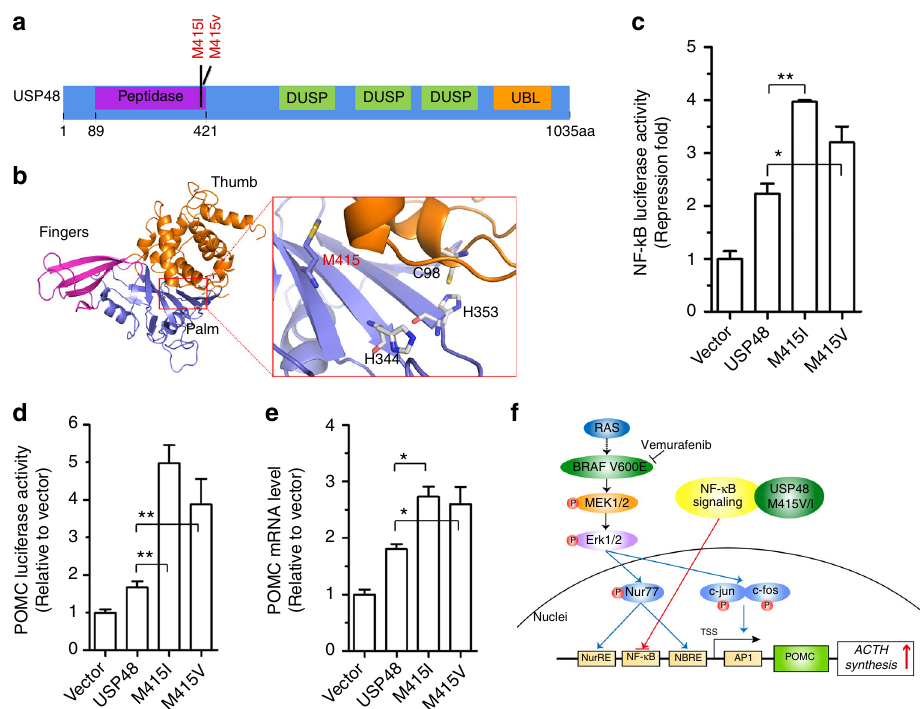
Fig. 3 USP48 mutants potentiate POMC promoter activity and ACTH production. a Schematic diagram of USP48 domains and location of the M415 residue. DUSP, domain presents in ubiquitin-speci fi c proteases; UBL, ubiquitin-like domain. b The modeling structure of peptidase domain of USP48. The crystal structure of USP7 (PDB ID: 1NBF) ubiquitin aldehyde (ubal)-binding form was used as the template to build the 3D structure of peptidase of USP48. The M415 residue is located in the catalytic palm, and three catalytic triads (C98, H344, and H353) are shown. c, d The NF- κ B reporter ( c ) or POMC promoter ( d ) activities in cells transfected with indicated expression vectors together with control vectors expressing renilla and luciferase. Data are ratios of luciferase activity/renilla activity and presented as the mean of three experiments. e Relative POMC mRNA levels in AtT-20 cells stably infected with indicated expression constructs. Data are expressed relative to empty control vectors after normalization to Hprt. Error bars represent SEM of three measurements. * P < 0.05, ** P < 0.01, two-tailed Student ’ s t -test ( c – e ). f Schematic representation showing the mechanisms by which BRAF V600E and USP48 mutants promote POMC transcription in corticotroph